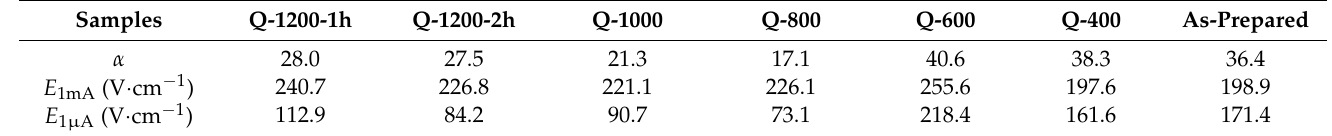
Figure 4. The J-E curves of ZnO ceramic samples quenched at different temperatures ( a ). Dependence of nonlinear coefficient α and activation energy of conductivity E σ λ ( b ) and electric fields at 1 mA/cm 2 and 1 µ A/cm 2 , i.e., E 1mA and E 1 µ A , ( c ) on the quenching temperature. Table 2. Electrical parameters of the quenched and as-prepared ZnO ceramic